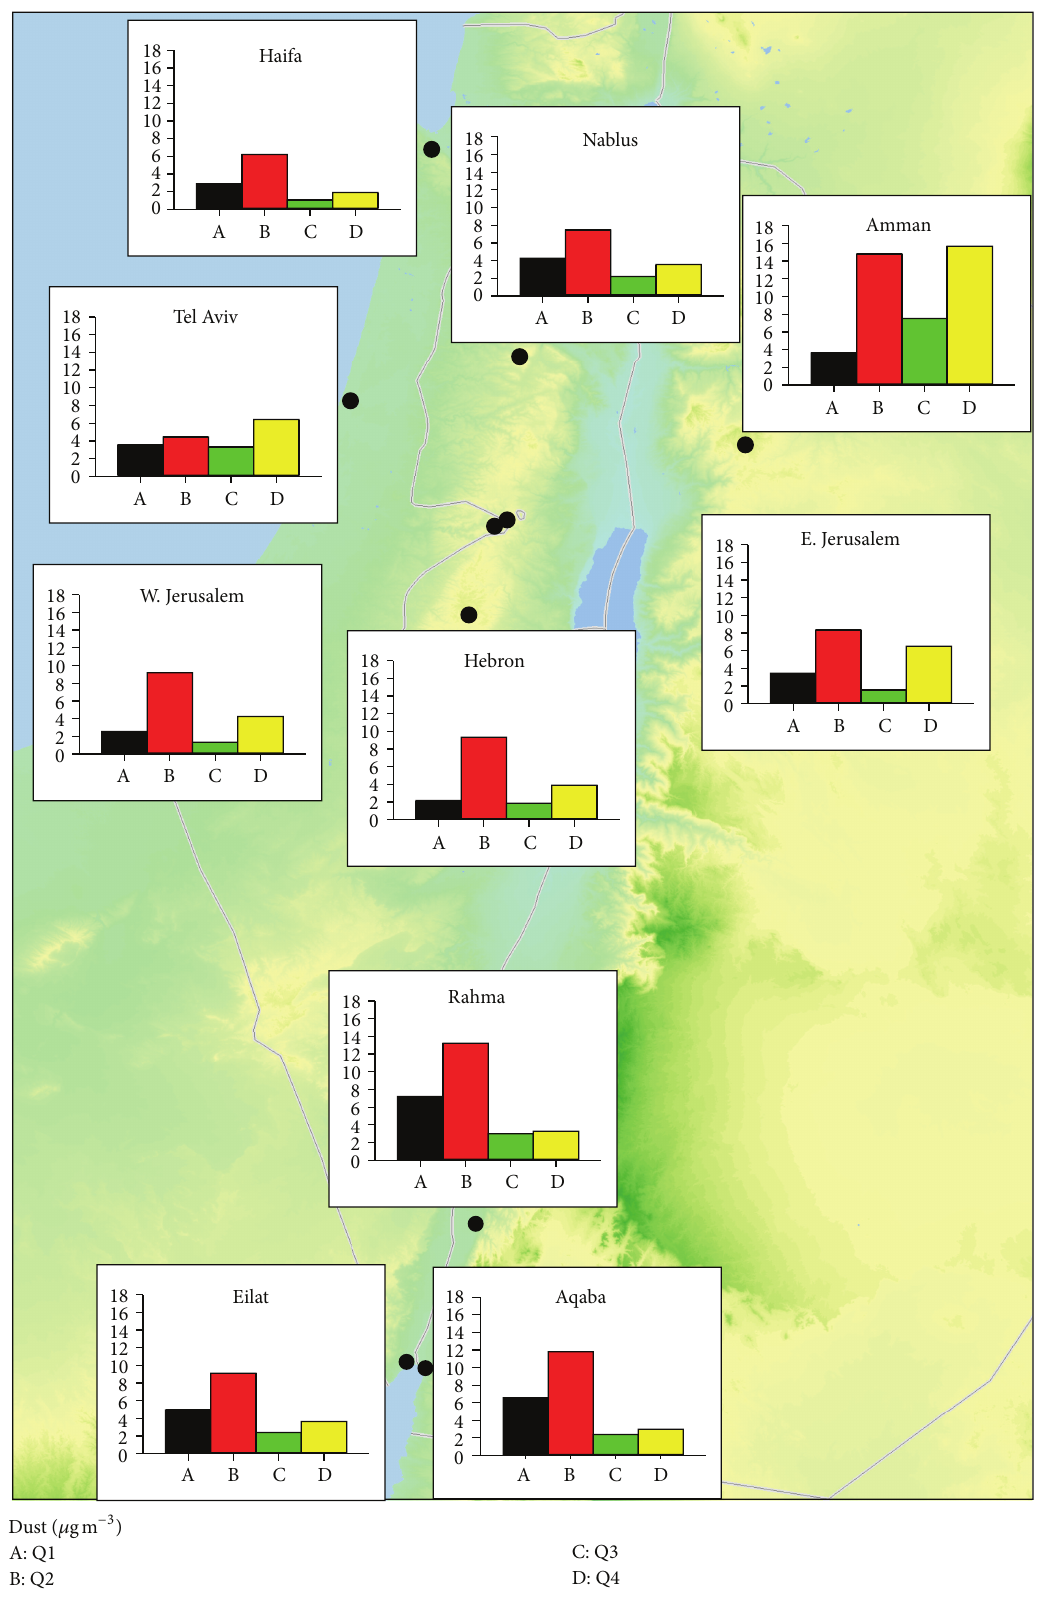
Figure 2: Seasonal trends of dust concentrations across